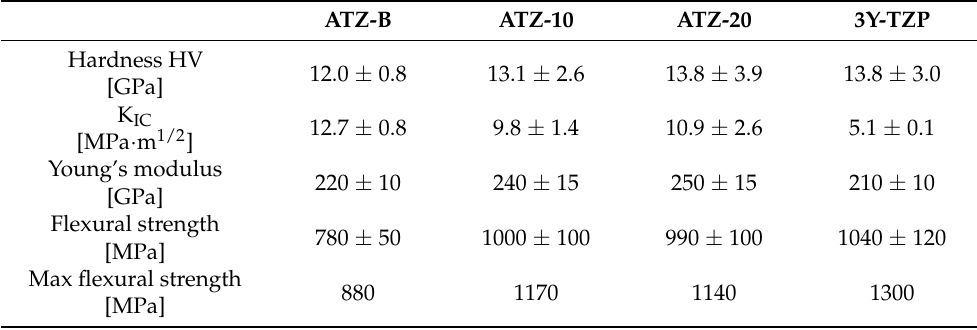
Table 3. Initial mechanical properties of the investigated ATZ ceramics (unaged) and 3Y-TZP reference